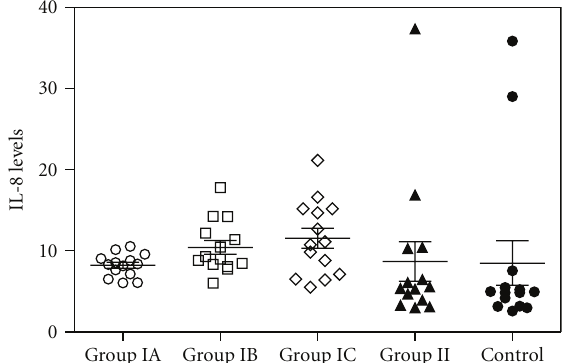
Figure 1: Plot graphic of serum IL-8 concentrations in all groups. The numbers of samples of the all groups are 14 for each. Group IA: severe persistent asthma patients before the treatment. Group IB: 4 months after the anti-IgE therapy, severe persistent asthma patients. Group IC: 18 months after the anti-IgE therapy, severe persistent asthma patients. Group II: newly diagnosed controlled allergic asthma patients. Group III: healthy individuals as control. P values were as below: Group IA versus IB: P = 0 . 02, Group IA versus IC: P = 0 . 019, Group IA versus II: P = 0 . 42, Group IA